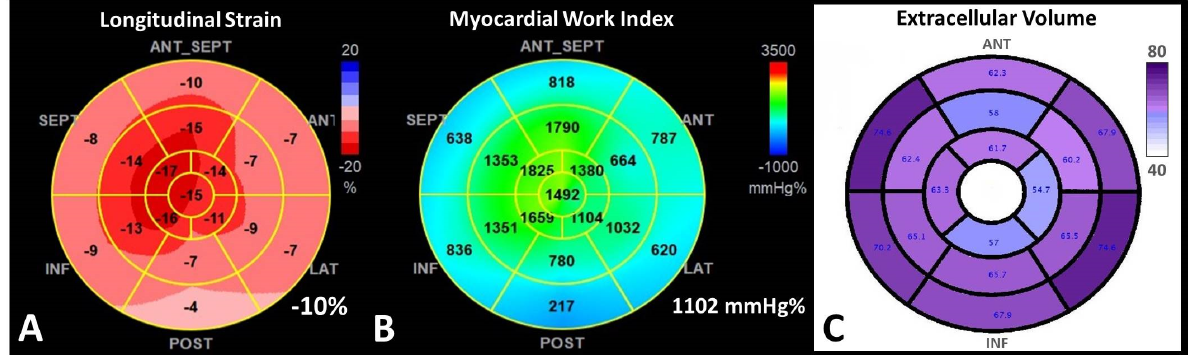
Figure 3. Apical sparing pattern in ATTR cardiac amyloidosis. ( A ) Longitudinal deformation bull’s eye plot of the left ventricle by speckle − tracking − echocardiography in a 46-year-old patient with ATTR-CM with significantly decreased global LS of − 10%, with longitudinal deformation impaired at the basal, midventricular segments, and relatively preserved at the apex, in an “apical sparing” pattern. ( B ) The corresponding myocardial work index (MWI) bull’s eye plot, confirming a similar apical sparing pattern, with preserved MWI in the apical segments; ( C ) Extracellular volume (ECV) bull’s eye plot evaluated by cardiac magnetic resonance, using a 16-segment model, displaying a progressive decrease in the ECV from base to apex, explaining the substrate of apical sparing deformation pattern.